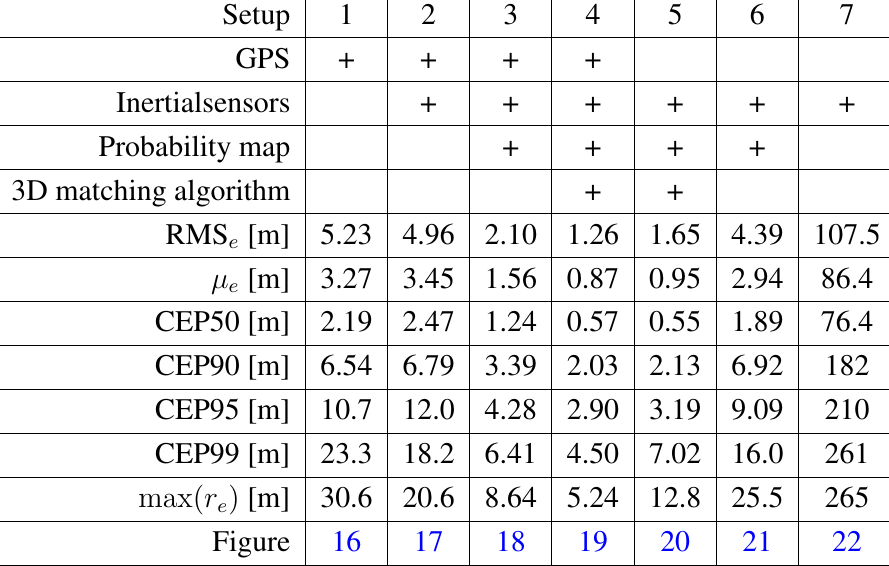
Table 1. Results of the trial at the University Campus. Seven setups of data sources were simulated. The sign ‘+’ in a column denotes that a given data source was included in the simulation. Otherwise the data source is not used. Setup number 4 was carried out with all data sources on. The results for this setup are